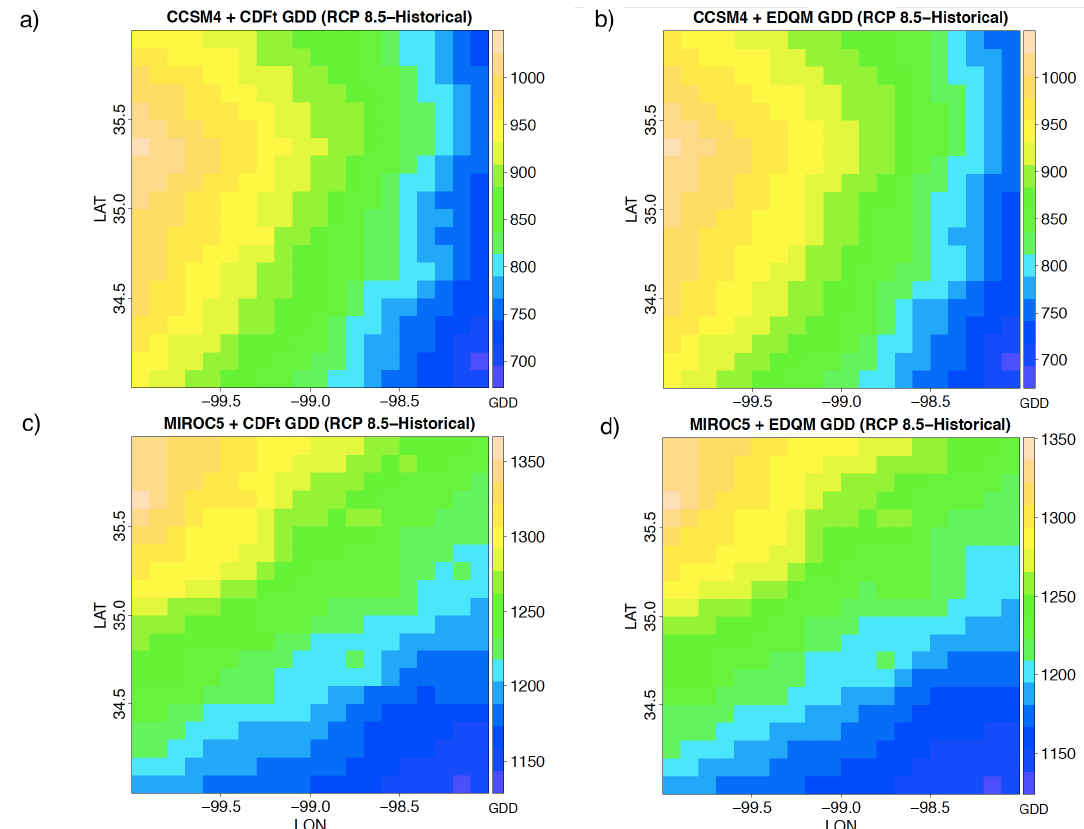
Figure 9. Mean differences between the outputs of the historical period (1961–2004) and the future period (2006–2098)—RCP 4.5 simulation. ( a ) outputs for the CCSM4 GCM and CDFt downscaling method. ( b ) outputs for the CCSM4 GCM and EDQM downscaling method. ( c ) outputs for the MIROC5 GCM and CDFt downscaling method. ( d ) the outputs for the MIROC5 GCM and EDQM downscaling method.